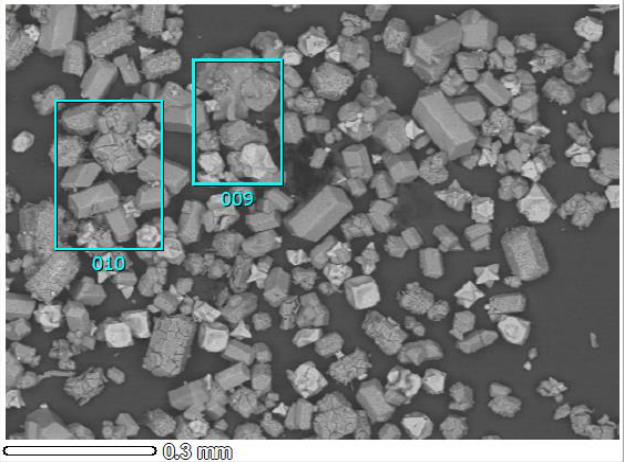
Fig. A.1. SEM image of ACH precipitated from the mother liquor with the outlined analyzed areas by EDX (the XRD pattern is Fig. 6).